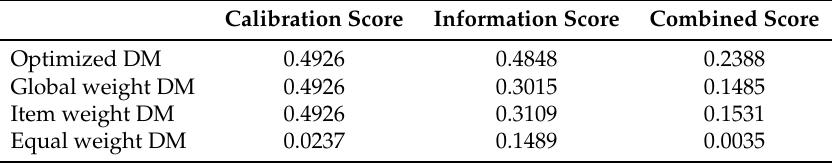
Table 5. Performance of the different Decision Makers for panel 4.